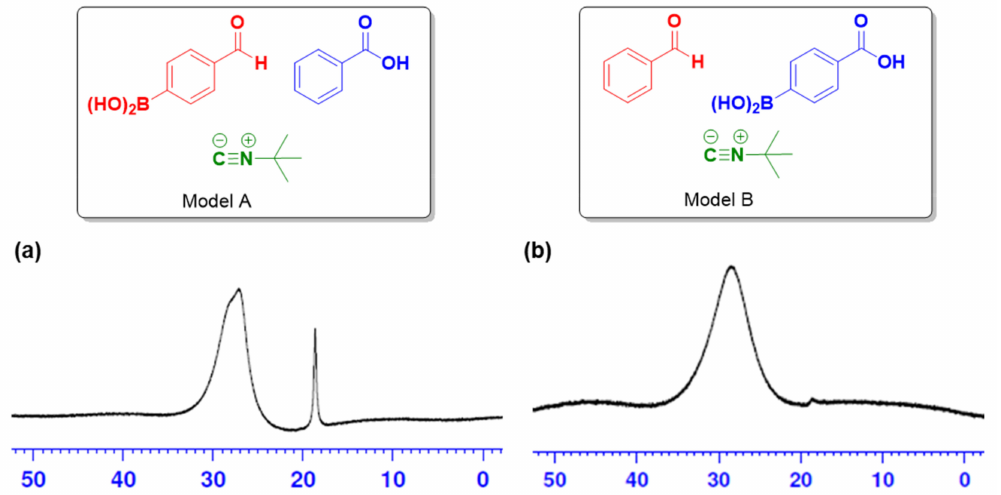
Figure 3. Two model reactions for 11 B NMR Study ( a ) Model A: Passerini-3CR with formylphenyl boronic acid; ( b ) Model B: Passerini-3CR with boronobenzoic